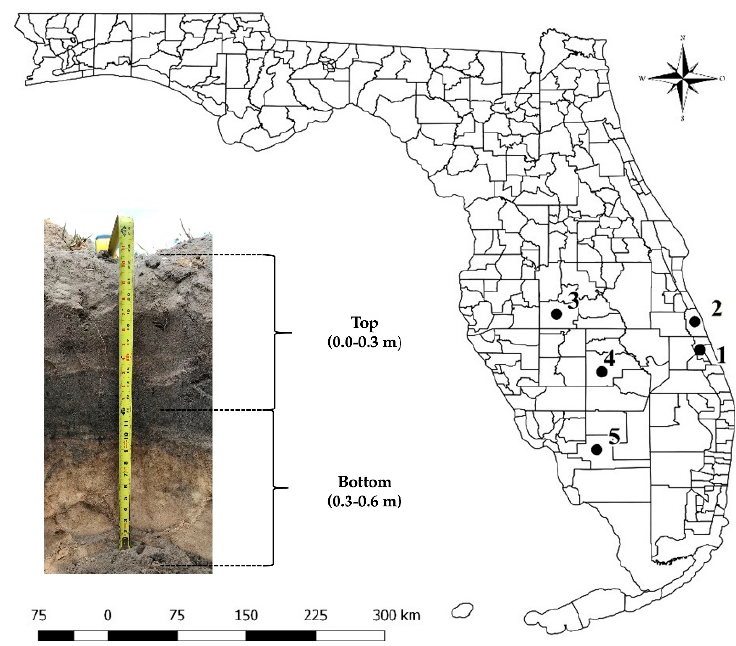
Figure 2. Location of the five sandy soils: Fort Pierce, FL - Pineda soil ( 1 ); Vero Beach, FL—Riviera soil ( 2 ); Fort Meade, FL—Candler soil ( 3 ); Lake Placid, FL - Astatula soil ( 4 ); and Immokalee, FL—Immokalee soil ( 5 ). Soils were sampled at two different depths (top and bottom layers at 0.0–0.3 and 0.3–0.6 m, respectively).